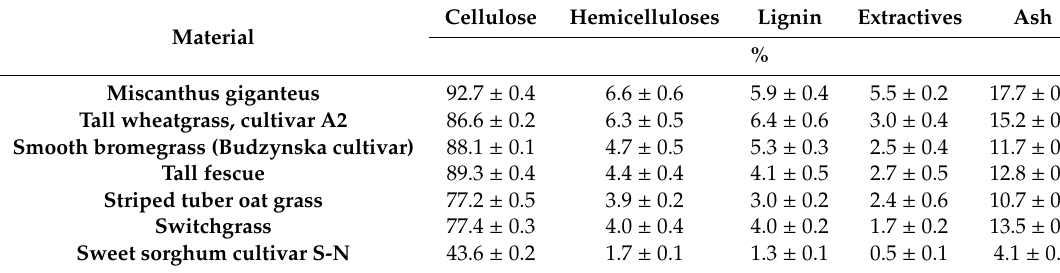
Table 4. Fraction of chemical compound retained in the